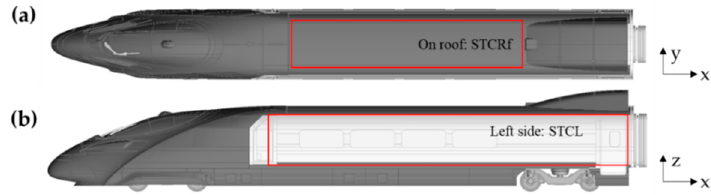
Figure 15. Surface regions of TC car for wavenumber–frequency analysis: ( a ) roof wall region; ( b ) left-side wall region.